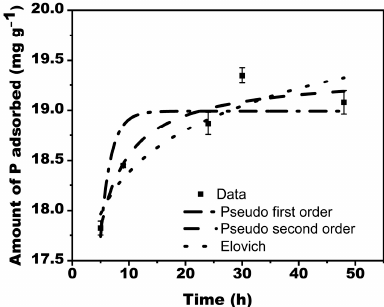
Figure 6. Phosphate adsorption kinetics for Douglas fir biochar treated with MgCl 2 · 6H 2 O + KOH